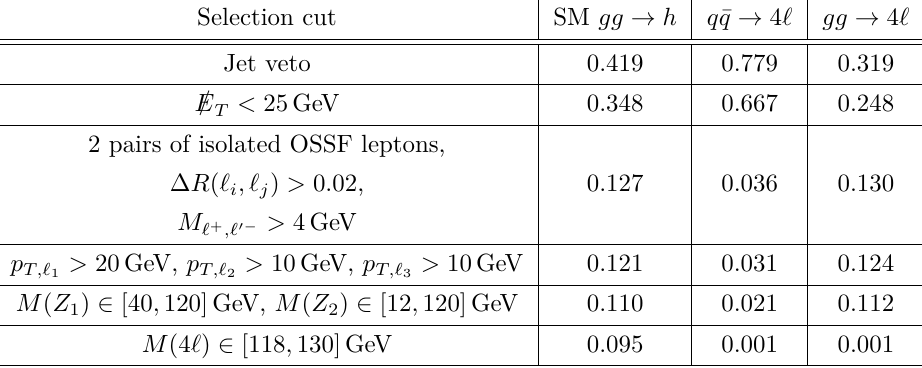
Table 2 . Set of cuts showing the impact of each stage of the selection on the fraction of retained Monte Carlo events for the SM-driven gg → h → 4 ‘ process, as well as on the q ¯ q → 4 ‘ and gg → 4 ‘ irreducible